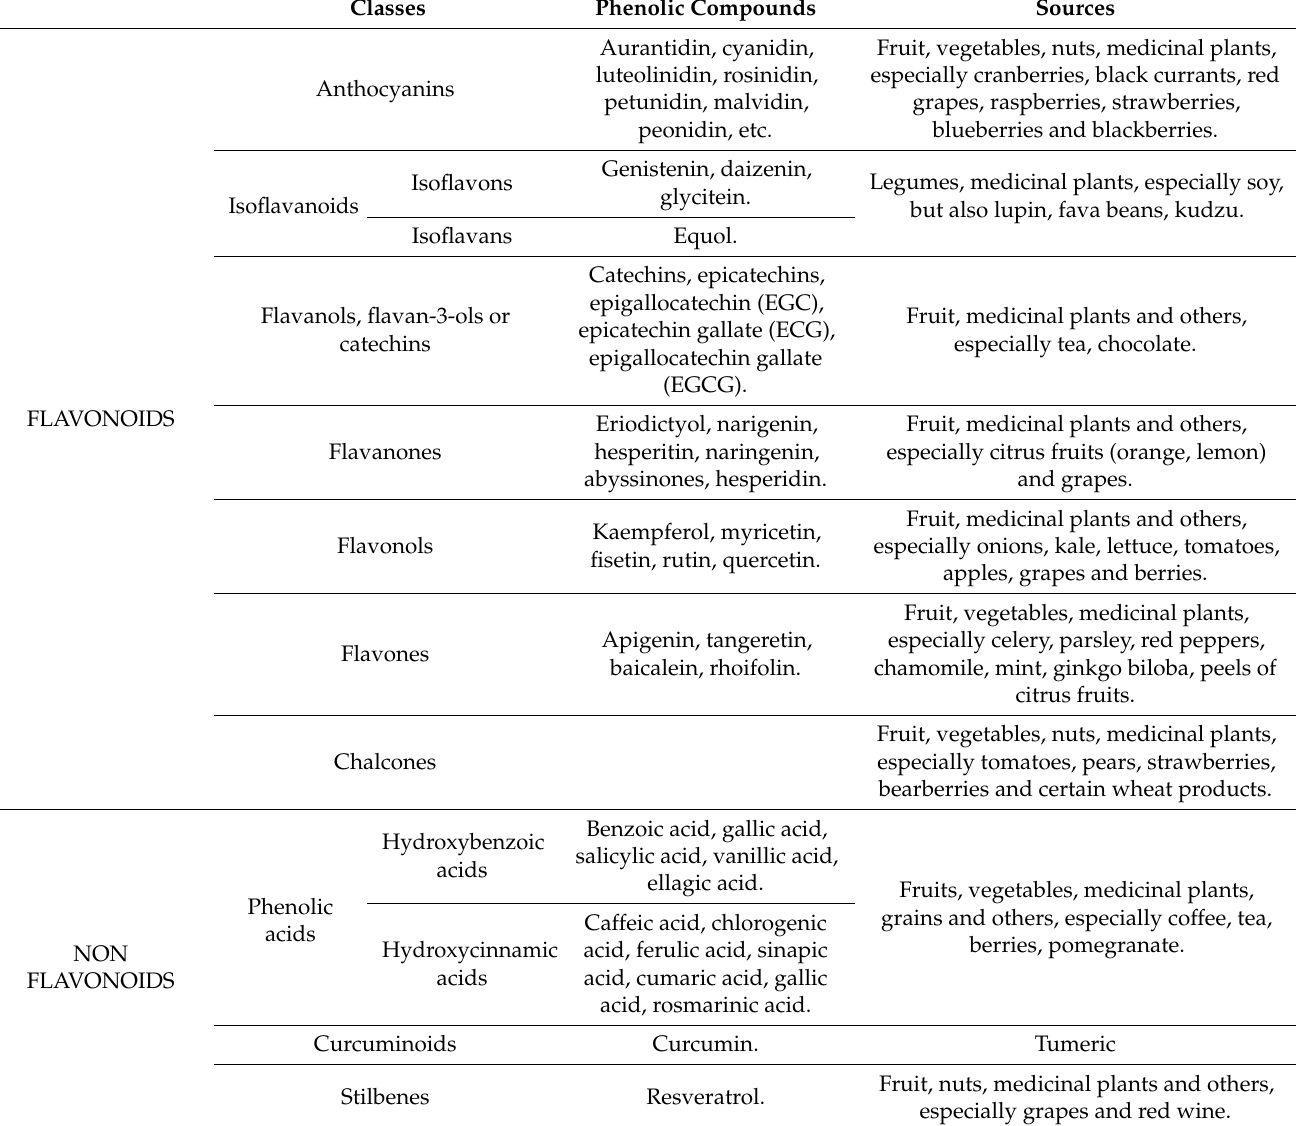
Table 3. A simple classification of naturally occurring plant